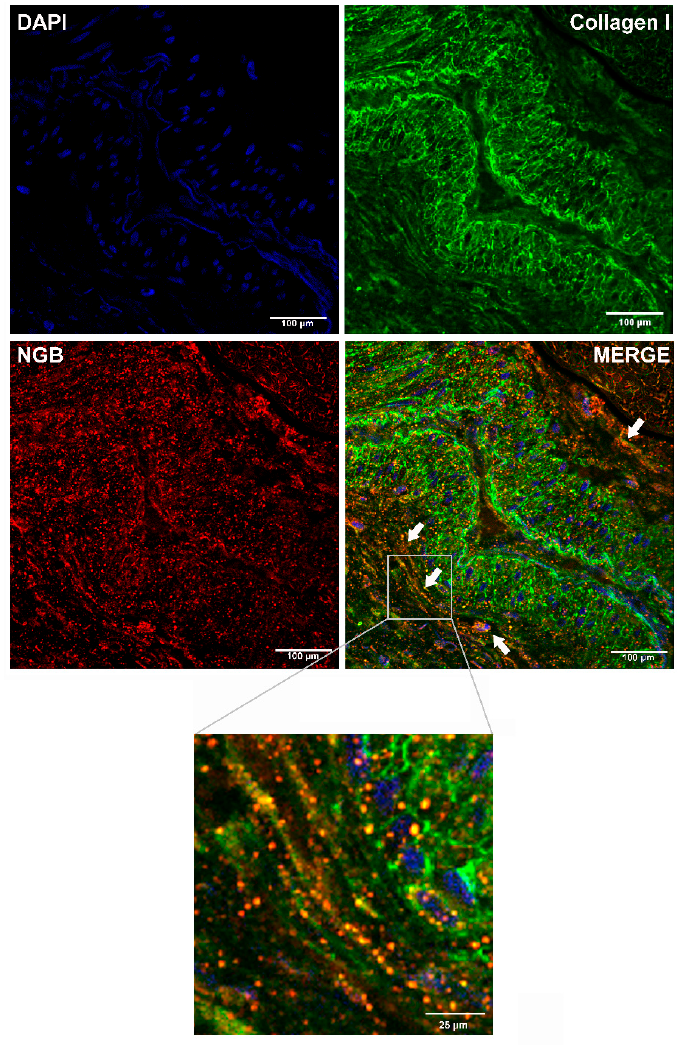
Figure 1. In vivo neuroglobin (NGB) extracellular localization. Confocal microscopy analysis of NGB and collagen I co-immuno-localization in human breast cancer tissue (ER α +; grade G2) sections. The sections were de-paraffinized, boiled in a microwave for antigen retrieval, blocked with 3% Bovine Serum Albumine (BSA) in Phosphate Buffered Saline (PBS) + Triton-X 100 0.5%, stained with 4',6-Diamidino-2-Phenylindole (DAPI) for nuclei (blue), the anti-NGB (red) and anti-Collagen I antibodies (green) (original magnification 40×). Co-immunolocalization between NGB and collagen I fibers (yellow signals) is indicated by white arrows in merged image. The gray square refers to merged image detail reported on the bottom as a digital magnification. The scale bars are 100µm/cm in the first 4 panels and 25µm/cm in the enlarged panel at the bottom. All images are single planes and are representative of 10 independent experiments.